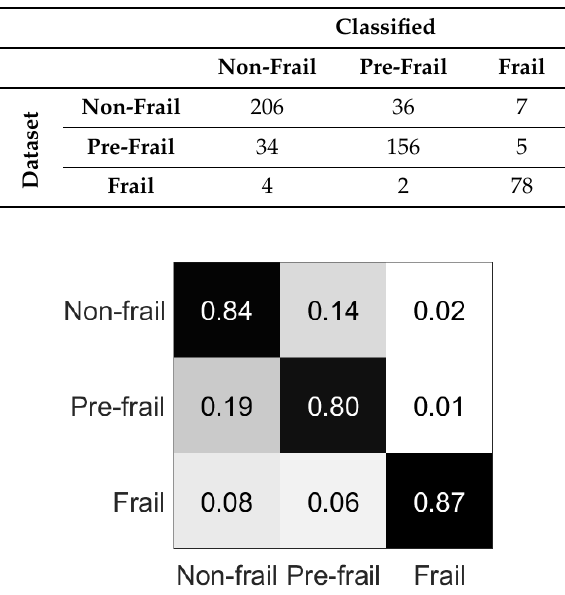
Table 5. Confusion matrix for the RF classifier for the assessment of the frailty status problem.